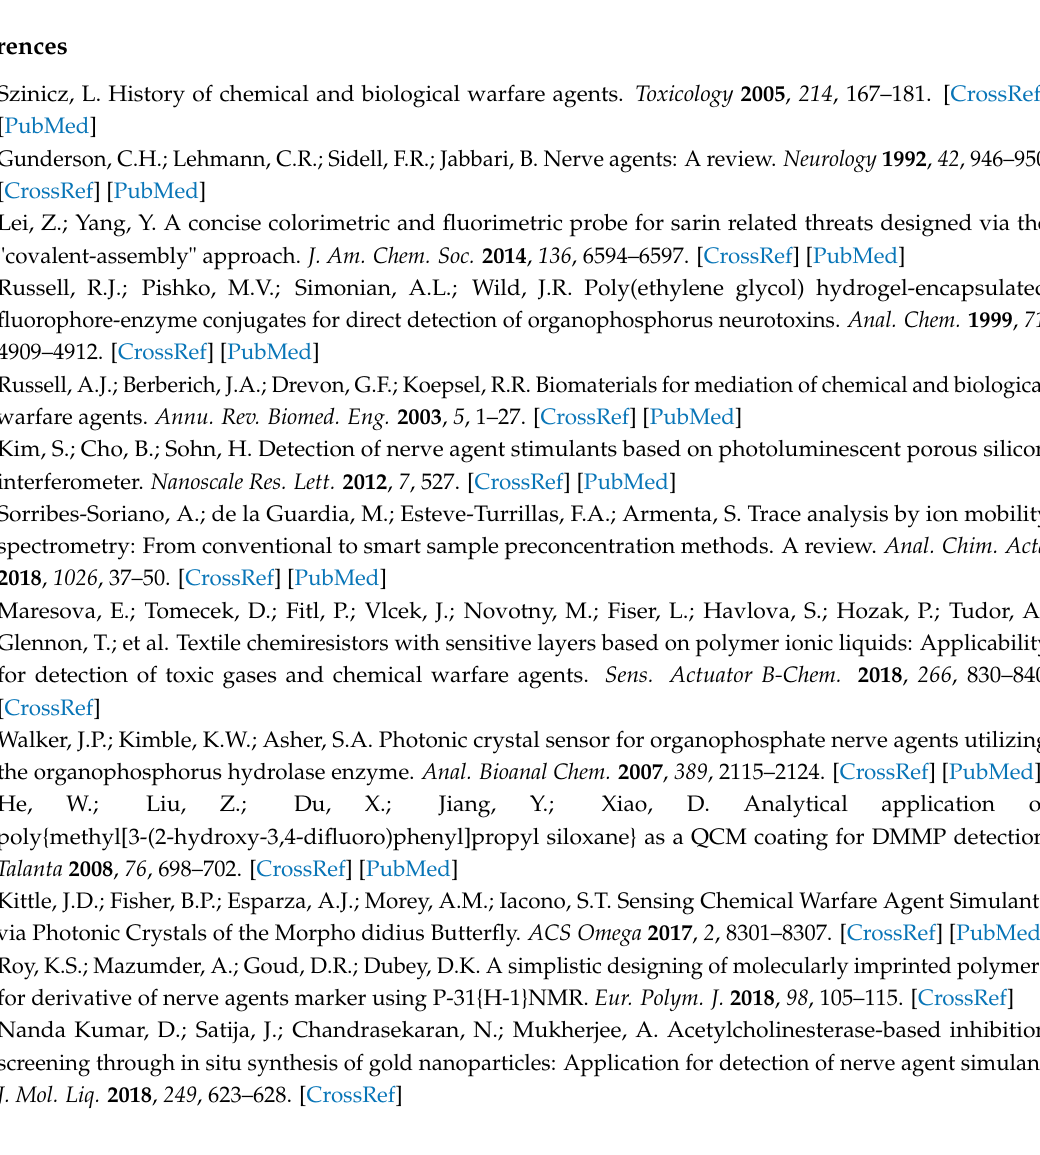
Supplementary Materials: The following are available online. Figure S1: The limit of detection for naked eye. Figure S2: Calibration plots by using fluorescence intensity of RB-CT (1 µ M) as a function of reaction time t in different DCP concentrations. Figure S3: ESI-MS spectrum of RB-CT/DCP adduct. Figure S4: 31 P NMR spectra of DCP and RB-CT with DCP in CD 3 CN. Figure S5: HOMO-LUMO energy levels of TD-DFT optimized geometries of probe and predicted RB-CT/DCP adducts. Figure S6: The plot of pH versus fluorescence intensity of free RB-CT and RB-CT+DCP. Figure S7: 1 H NMR Spectrum of Compound 1. Figures S8 and S9: 1 H NMR and ESI-MS Spectra of